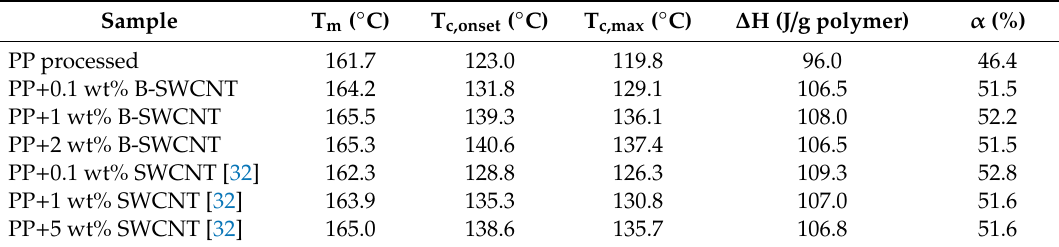
Table 2. DSC results of PP composites filled with B-SWCNTs or SWCNTs.